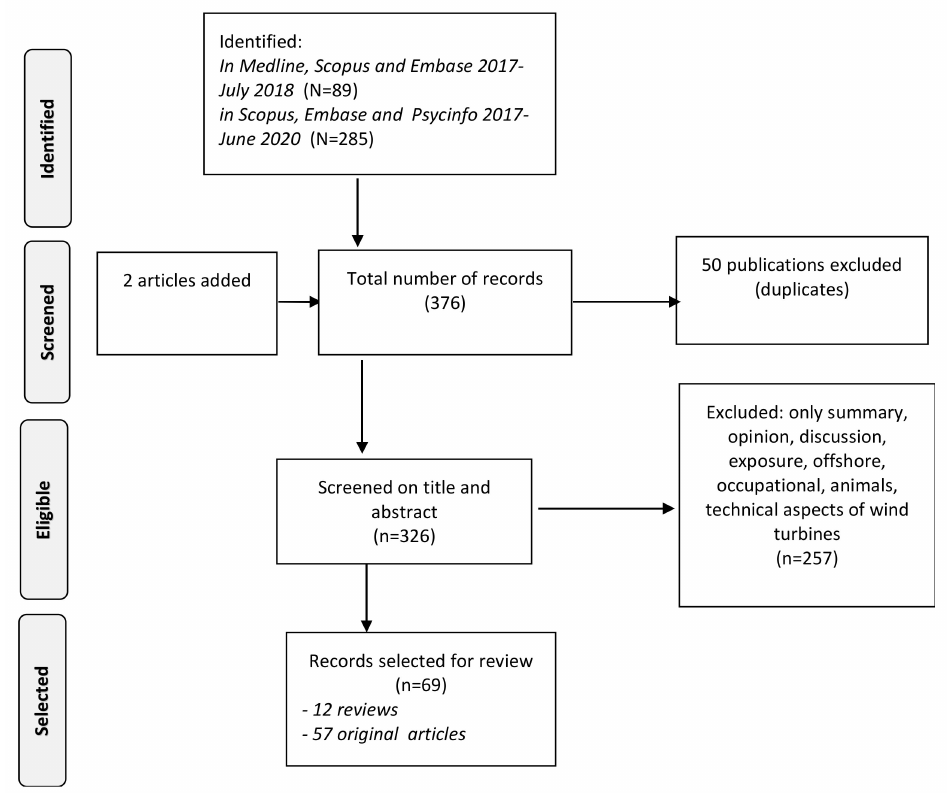
Figure 1. Flowchart of selection